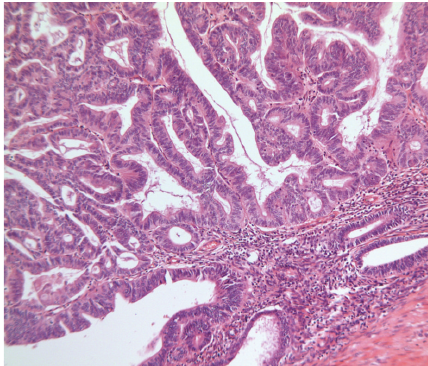
Figure 2: Endometrioid adenocarcinoma (left) adjacent to endo- metriosis and muscularis (bottom right).